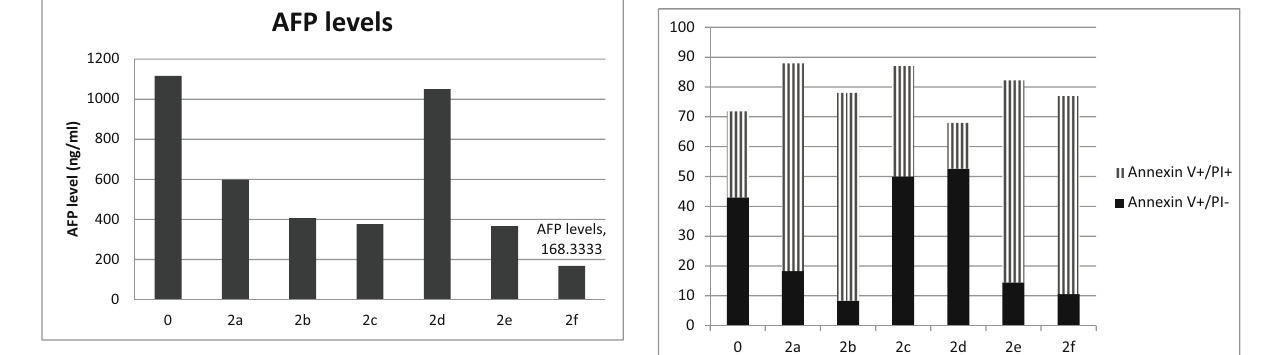
Figure 5: Necrosis versus apoptosis of the synthesized